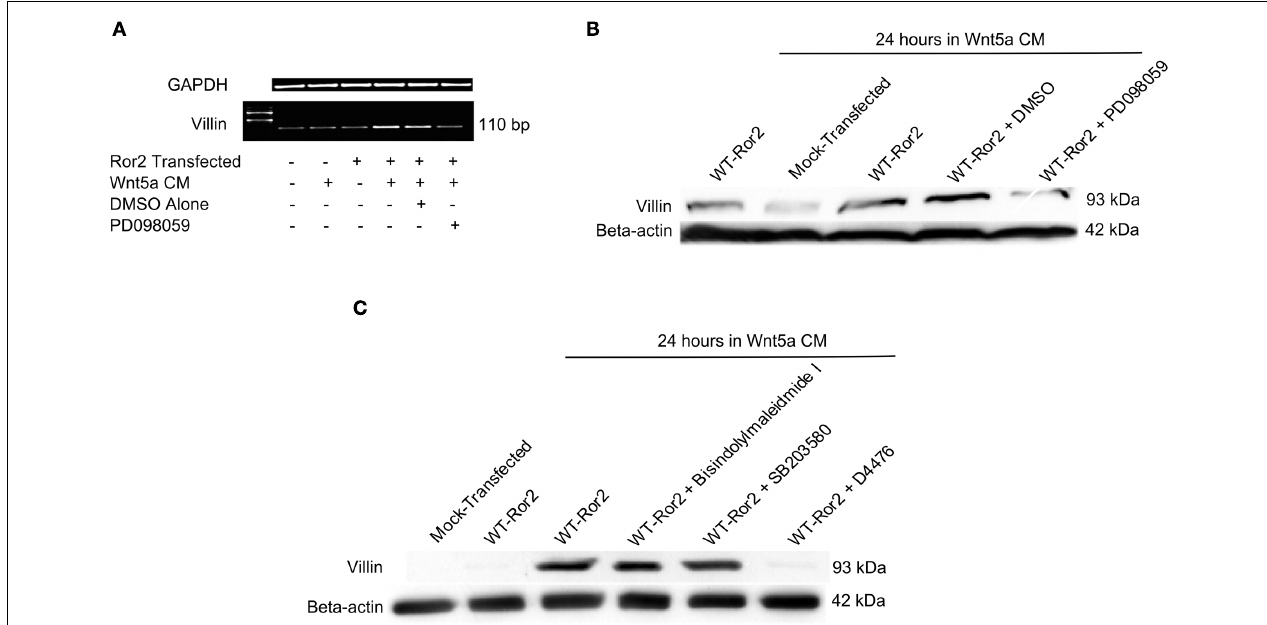
internal loading control. (C) Inhibitors of PKC (Bisindolylmaleimide I; 1 μ M) and p38 (SB 203580; 1 μ M) did not, but a CKI inhibitor (D4476; 100 μ M) did preventWnt5a-induced villin protein increases. Immunoreactive villin, at levels similar to that ofWnt5a-treatedWT Ror2-transfected